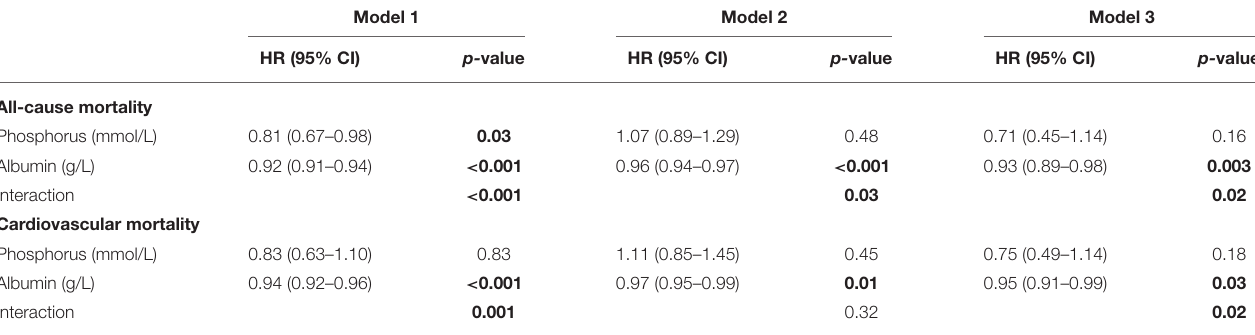
TABLE 3 | Interaction and association of albumin and phosphorus with all-cause mortality and cardiovascular mortality.